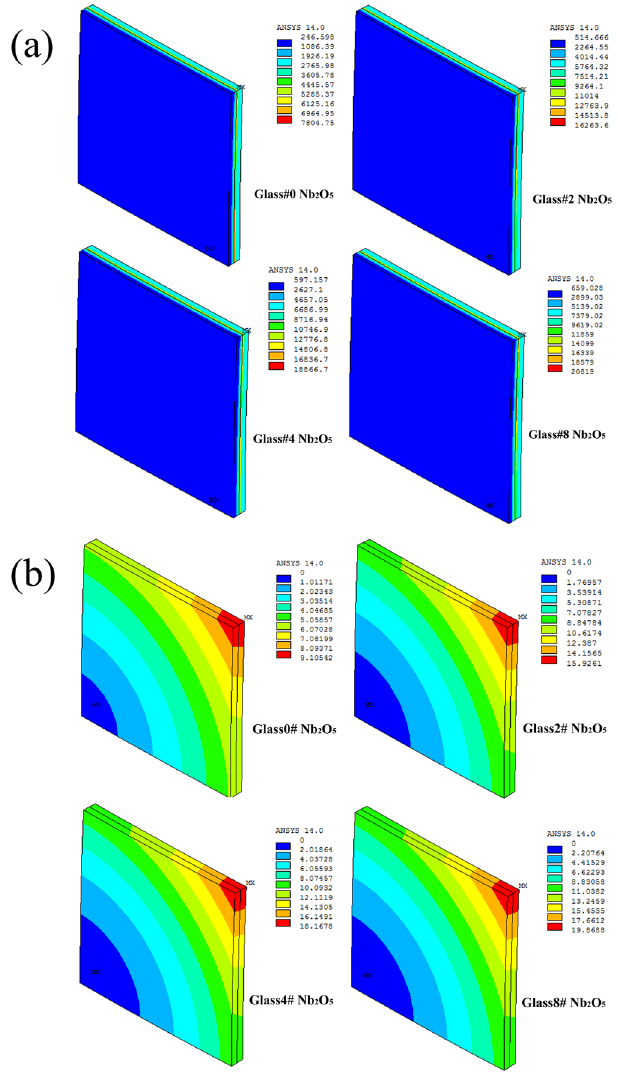
Figure 2. ( a ) The stress distribution and its magnitude at the glass/metal interface after thermal cycling for 50 times. ( b ) The displacement for the sealing couple between glass and Crofer 22APU after thermal cycling for 50 times.